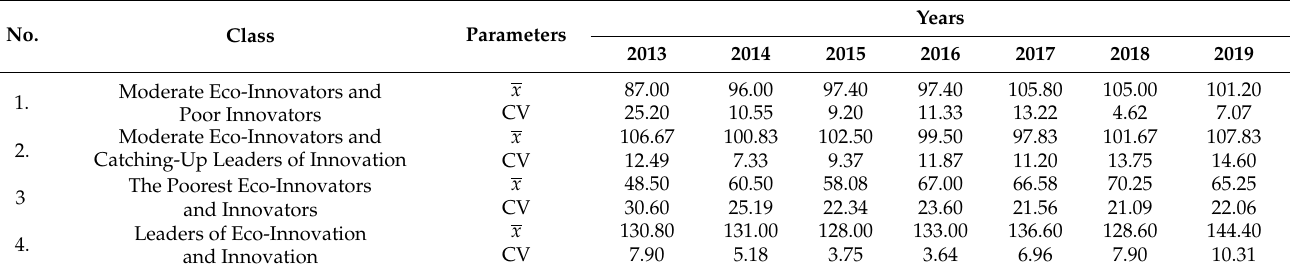
Table 5. Descriptive parameters of the Eco-Innovation Index value for the selected types of classes of the European Union countries in the years 2013–2019 (EU average =